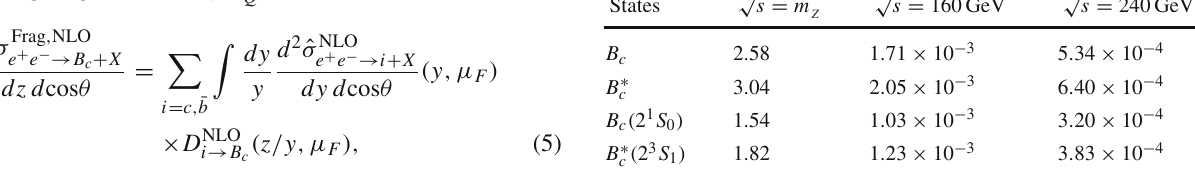
Table2 Theexpectednumbersofthe B c , B ∗ c , B c ( 2 1 S 0 ) ,and B ∗ c ( 2 3 S 1 ) events to be generated via the three planned modes of the CEPC √ √ s = m s = 160GeV States Z